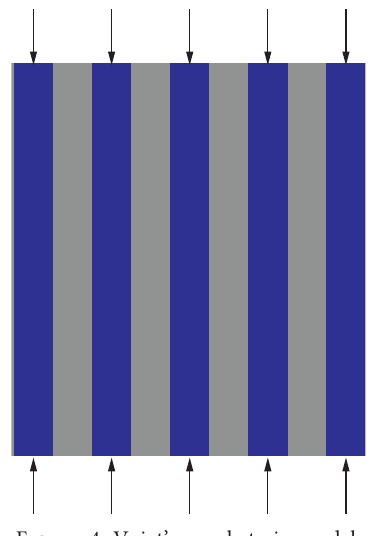
Figure 4: Voigt’s equal strain